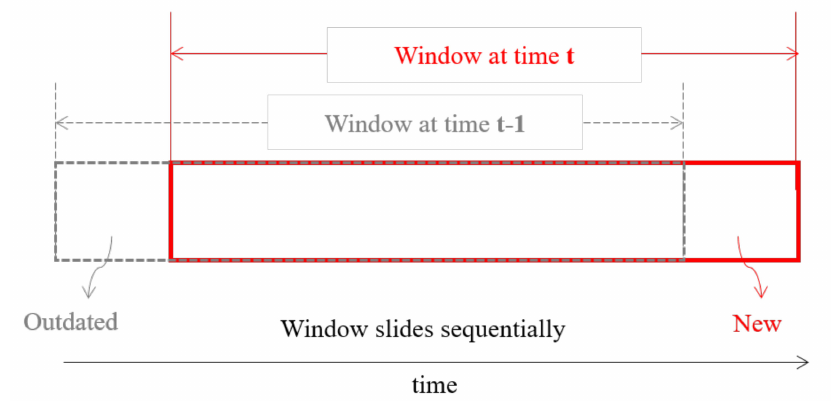
Figure 5. The sliding window procedure during incremental learning from t − 1 to